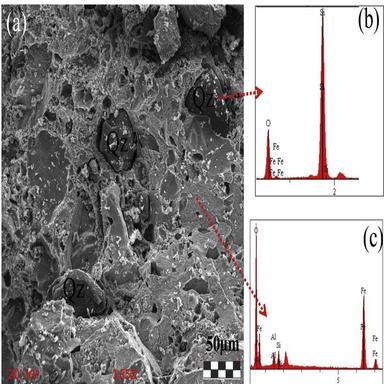
Compressive resistance (CR) test behaviour for lateritic crust (sample SJ.R.02/15) and ferruginous sandstones (sample SJ.R.06/14) from the FSJM and outcrops at the Pedreira River (RP.R.04/14), which in this case are identified as possible sources of raw material.